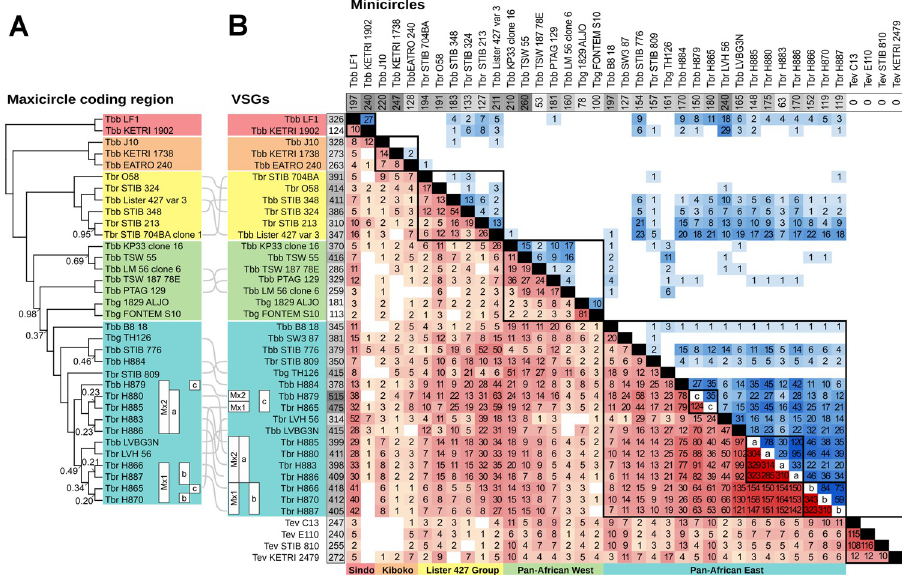
Fig 5. Shared VSG s and kinetoplast DNA minicircles among field-collected isolates of subgenus Trypanozoon . A. Phylogenetic tree of the maxicircle coding region of T . brucei isolates, excluding SW3/87, which produced a fragmented maxicircle on assembly. Node values show posterior probabilities < 1. Isolates are grouped by colour: red, Sindo; orange, Kiboko; yellow, Lister 427 group; green, Pan-African West; cyan, Pan-African East. In this last group, two clades are evident among Ugandan isolates (Mx1 and 2), and the VSG cluster (a, b, c) is also shown. B. Data matrices of shared VSG s (red) and minicircles (blue) from 39 isolates of subgenus Trypanozoon . Higher values are indicated by darker colour. The grey boxes in the horizontal row and vertical column show total numbers of minicircles and VSG s recovered, respectively. Isolates are grouped by colour largely as in A, with SW3/87 now included in the cyan group and other small changes within group to highlight shared VSG s. As T . evansi isolates have only one major minicircle type, minicircle data is voided. For the Ugandan isolates, the VSG cluster (a, b, c) is indicated on the